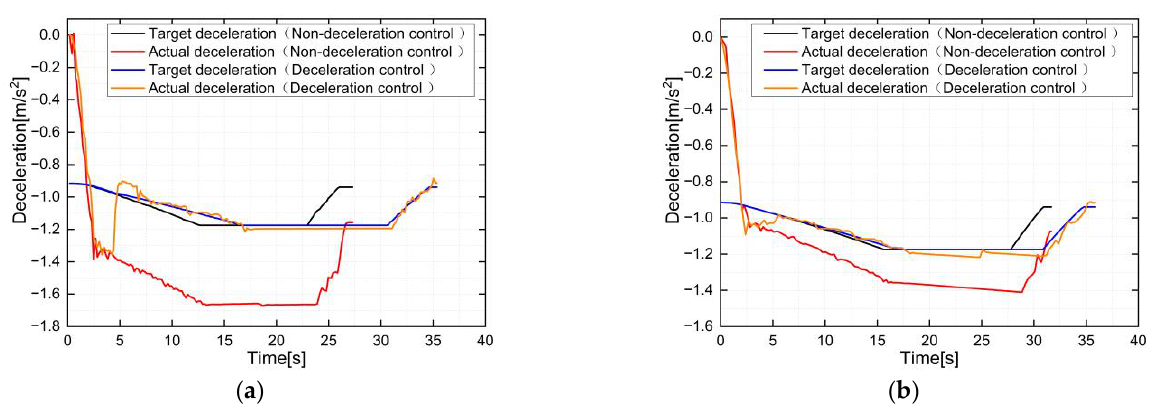
Figure 10. Test results with uncertain brake pad friction coefficient: ( a ) the brake pad friction coef- ficient is 0.5; ( b ) the brake pad friction coefficient is 𝑓 = 0.43 − 0.0003 × 𝑣 ( 𝑣 is the train speed). Table 3. Test results of each